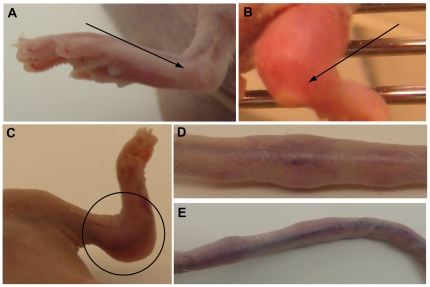
Symptoms observed at day 30 post-infection in nu/nu mice infected i.n. with CML1.Note the vesicles localized on the leg (A and B), the swelling of the joint of the leg (B and C), and the presence of lesions along the tail (D and E). Similar symptoms are seen with i.c. infection.